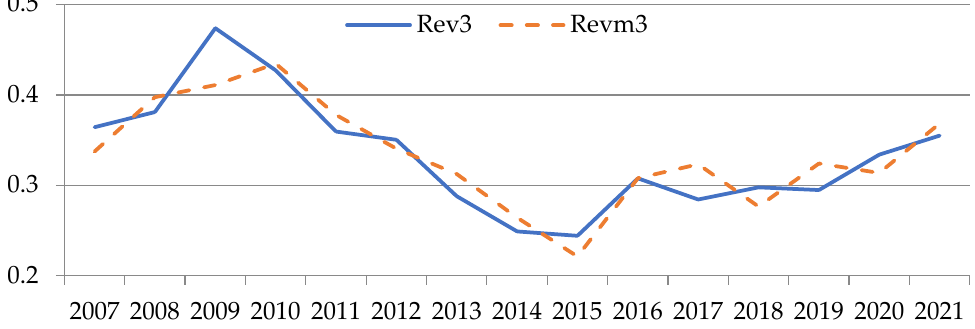
Figure 3. Comparison between real revenue and model value calculated by Formula (1) for industry No. 3 (author’s results).